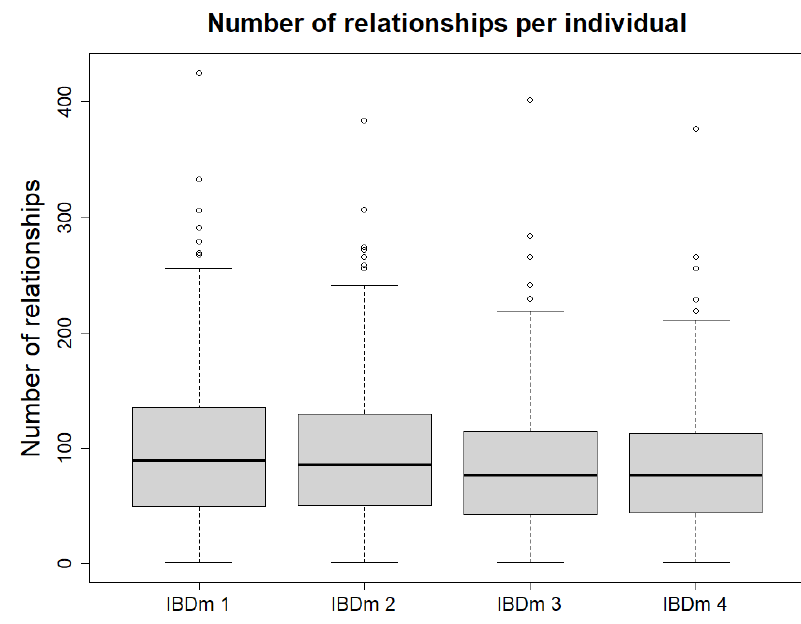
Figure 4. Boxplot of the number of relationships per individual for the 4 IBD matrices.